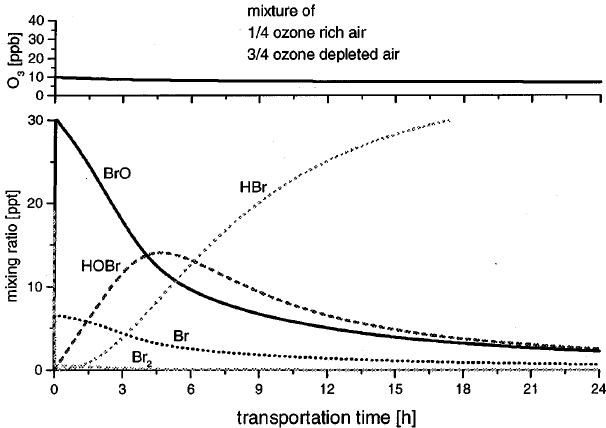
Fig. 14. Model calculation: time dependent development of O 3 and bromine compounds for a mixed airmass and no heterogeneous chemistry